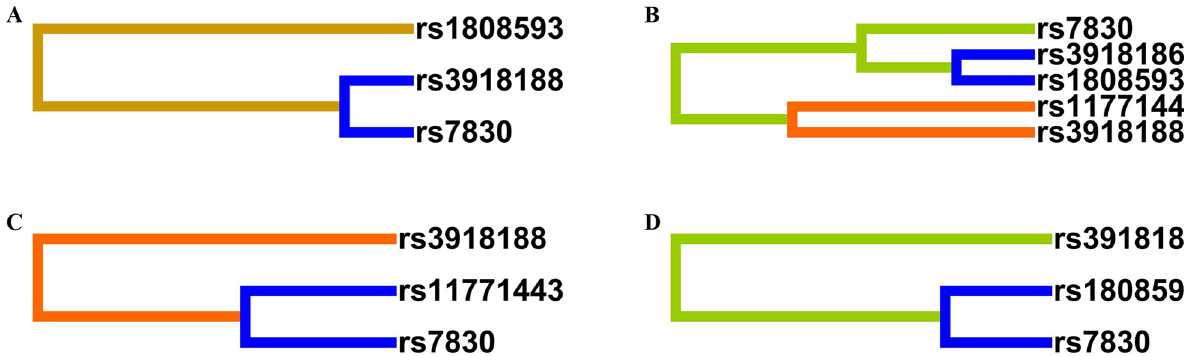
Fig 2. The dendograms of the SNP-SNP interaction in Guizhou populations. (A) SNP-SNP interaction of Miao population. (B) SNP-SNP interaction of Buyi population. (C) SNP-SNP interaction of Han population. (D) SNP-SNP interaction of Guizhou total